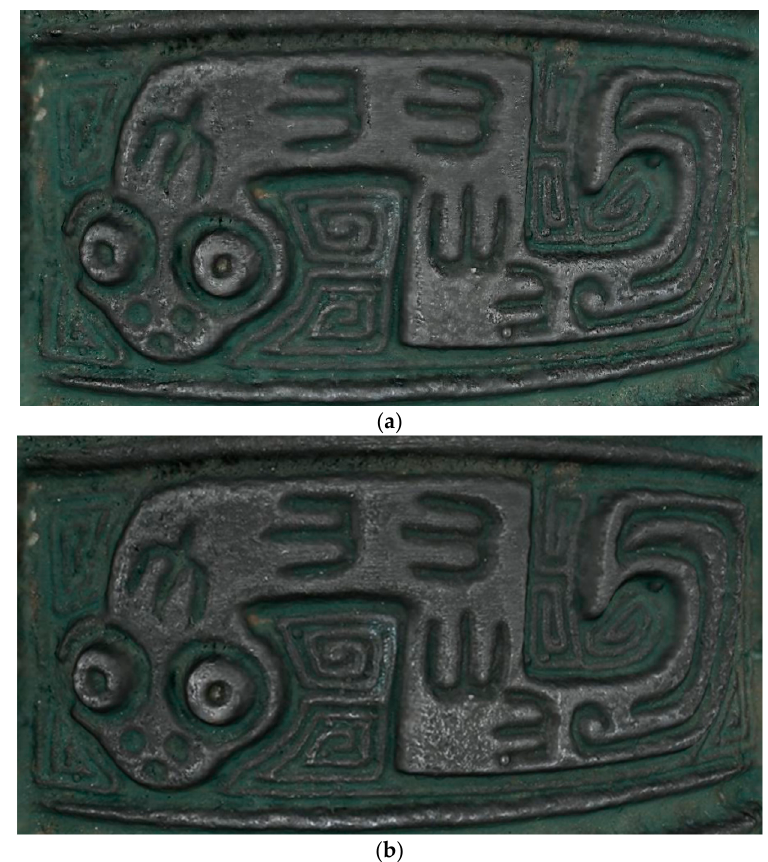
Figure 9. Three-dimensional model before and after texture selection of exposure quality selection. ( a ) Texture-exposure index evaluation before selection; ( b ) texture-exposure index evaluation after selection.